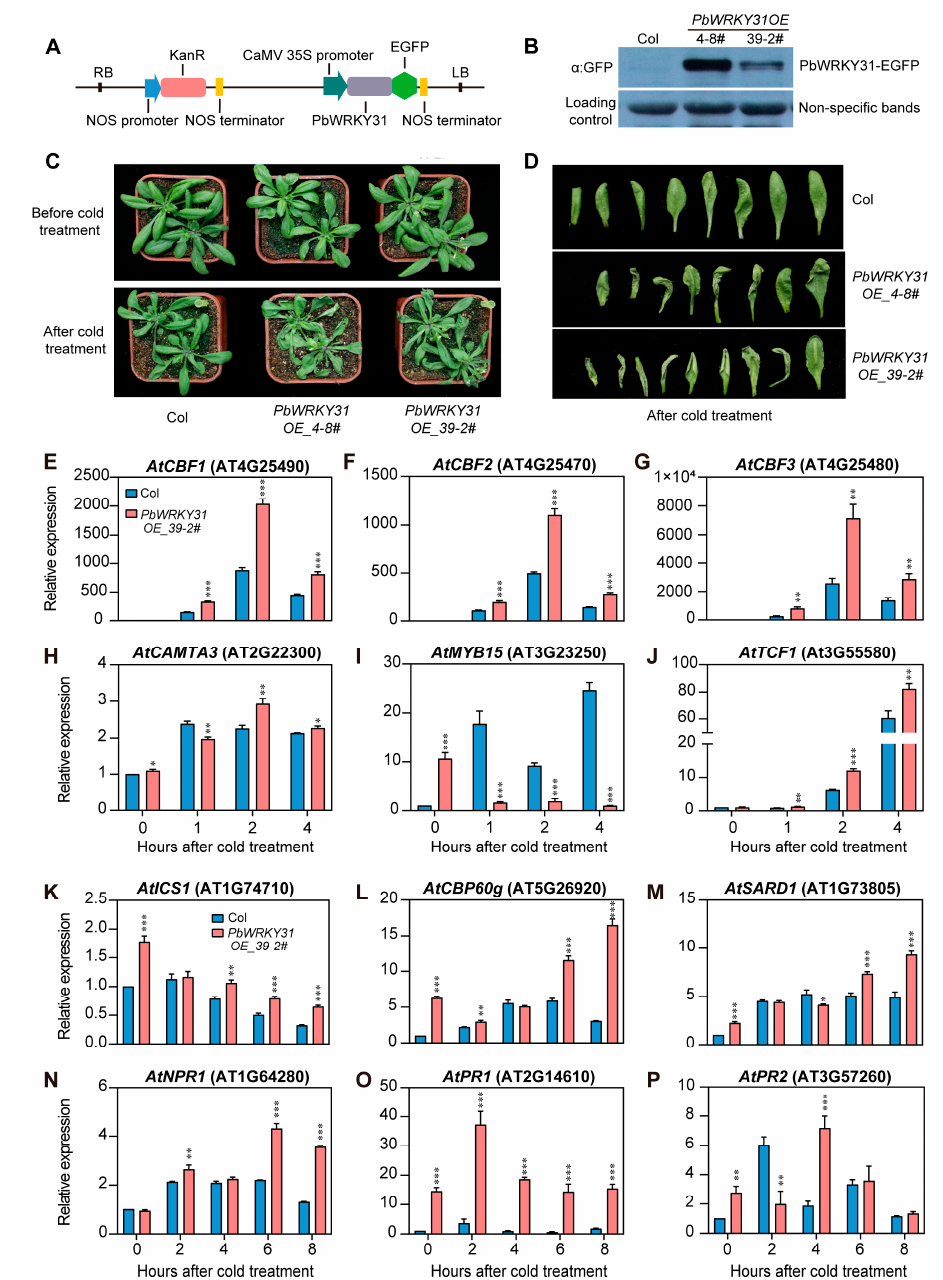
2.9. Overexpression of PbWRKY31 Increases Cold-Sensitivity in Arabidopsis To investigate the role of PbWRKY31 in regulating plant cold sensitivity, the p35S- PbWRKY31-GFP vector containing a kanamycin selection marker was transformed into Arabidopsis (Figure 9A). Two independent homozygous lines of PbWRKY31OE_4-8# and PbWRKY31OE_39-2# were confirmed via immunoblotting and used for the phenotypic analysis (Figure 9B).